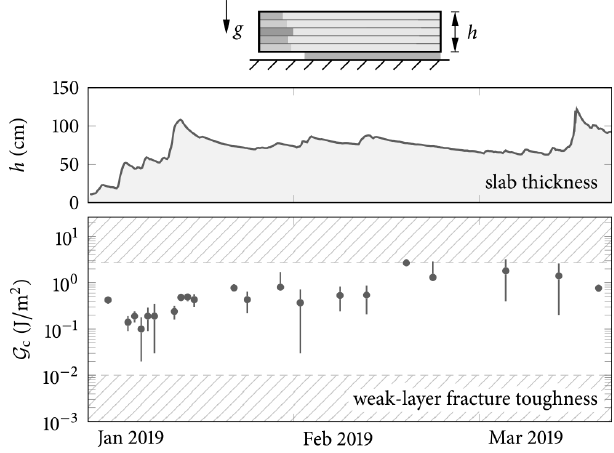
Figure 10. Weak-layer fracture toughness determined with the present model from critical cut lengths of 21 flat-field propaga- tion saw tests (PSTs) throughout the 2019 winter season on the same surface-hoar weak layer covered by a layered slab of chang- ing thickness (Bergfeld et al., 2023a, b). All results are within the hatched boundaries, indicating the thus far lowest and highest pub- lished fracture toughness of weak layers, 0.01Jm − 2 (Gauthier and Jamieson, 2010) and 2.7Jm − 2 (van Herwijnen et al., 2016), respec-